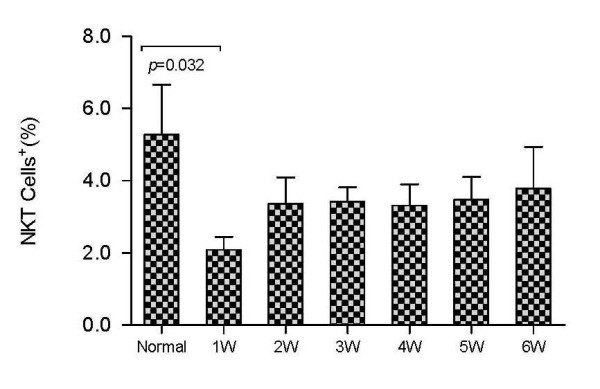
Levels of NKT cells in either healthy control group (Normal) or AHB patients at different weeks (1 W - 6 W) after being admitted to hospital.